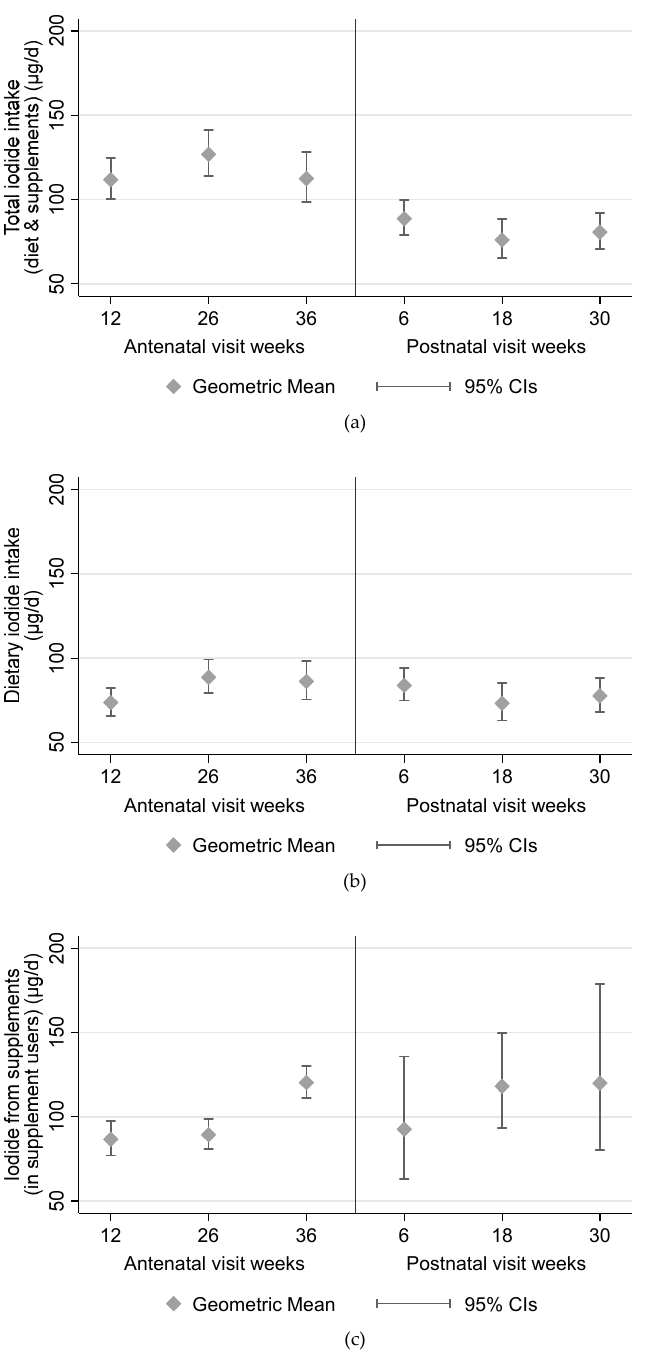
Figure 1. Iodide intake during pregnancy and postnatally. ( a ) Total intake; ( b ) dietary intake; ( c ) supplemental iodide intake amongst users of iodide supplements.